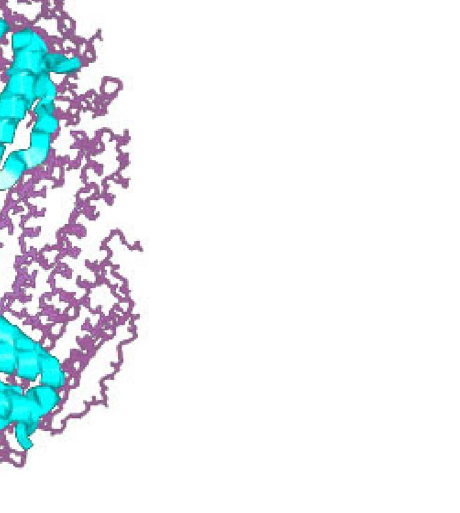
Figure 1. Ferritin structure. (Source :